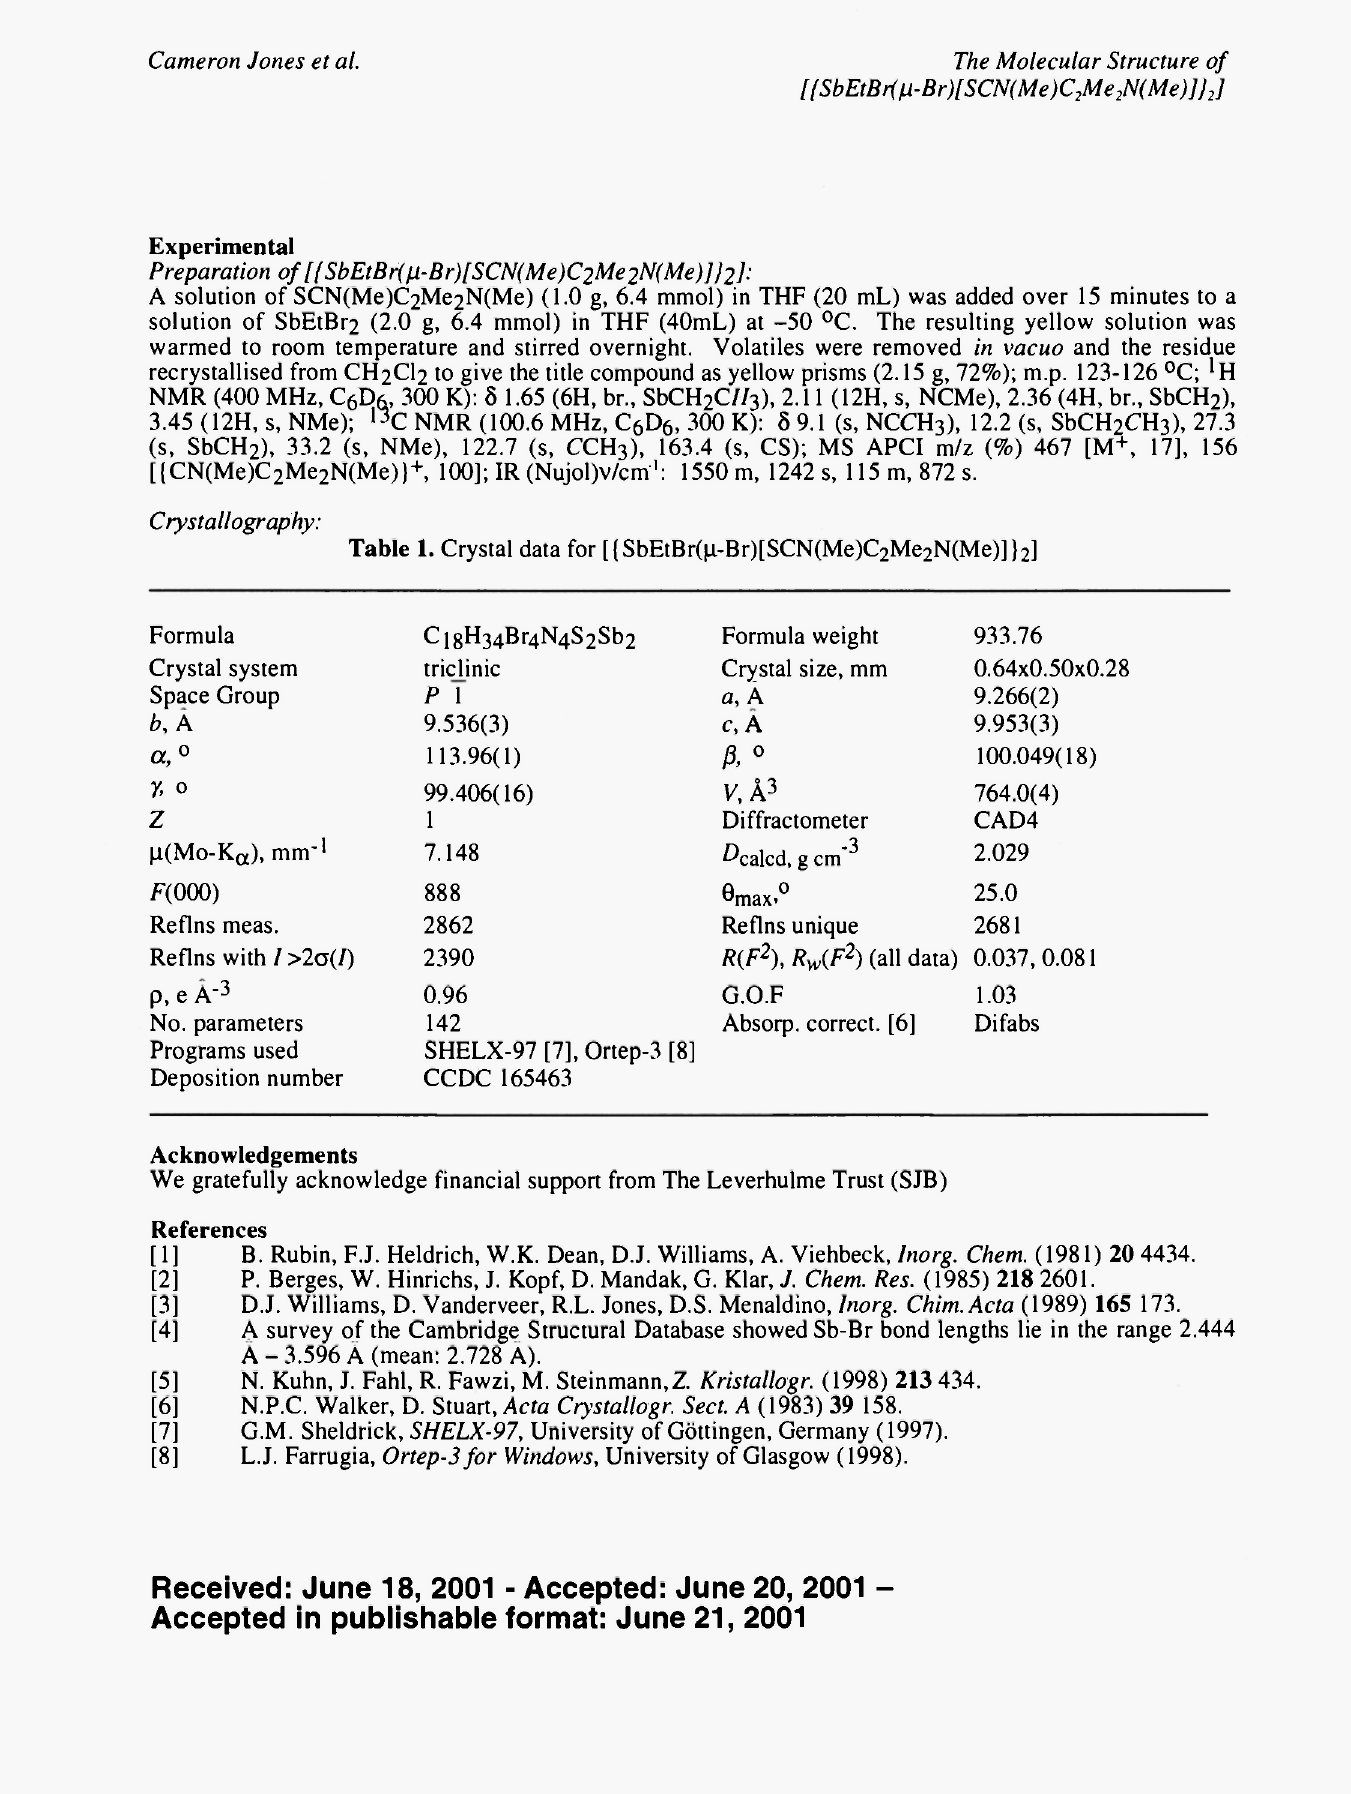
Table 1. Crystal data for [{SbEtBr(H-Br)[SCN(Me)C 2 Me 2 N(Me)]} 2